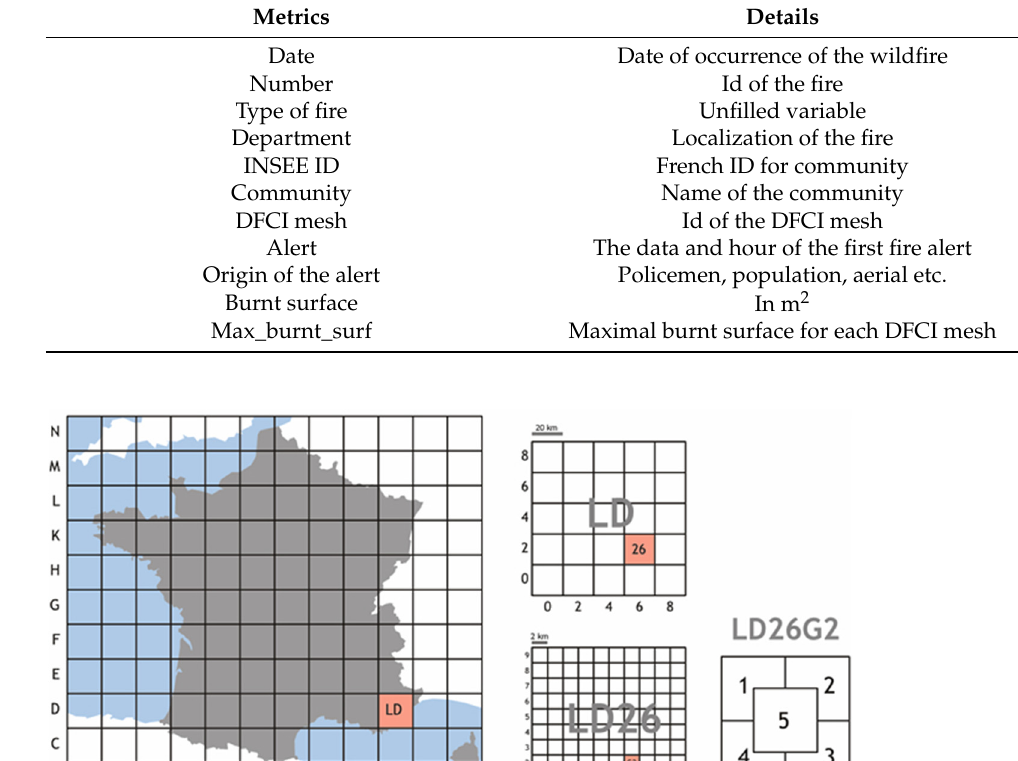
Table 2. EURO-CORDEX and Climsec data.